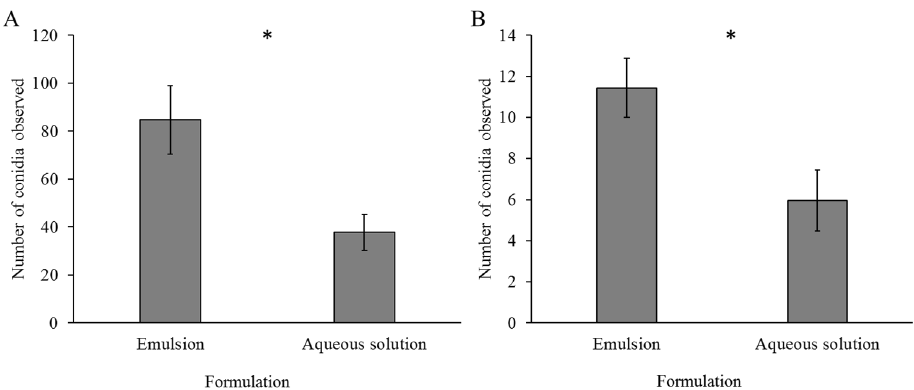
Figure 5. Mean number (±SE) of conidia unbound ( A ) or bound ( B ) to larvae, by formulation. To assess conidial attachment S. littoralis first instar larvae were exposed to leaf segments treated with conidia formulated in either aqueous solution or emulsion. After 24 h of exposure, larvae were examined under a confocal microscope to quantify the number of conidia. Larvae were not washed for acquisition or washed with tap water for adhesion. A least square analysis was employed, * indicates significant difference between formulations (FA = 4.3518, pvA = 0.0463, FB = 16.1616, pvB = 0.0002).